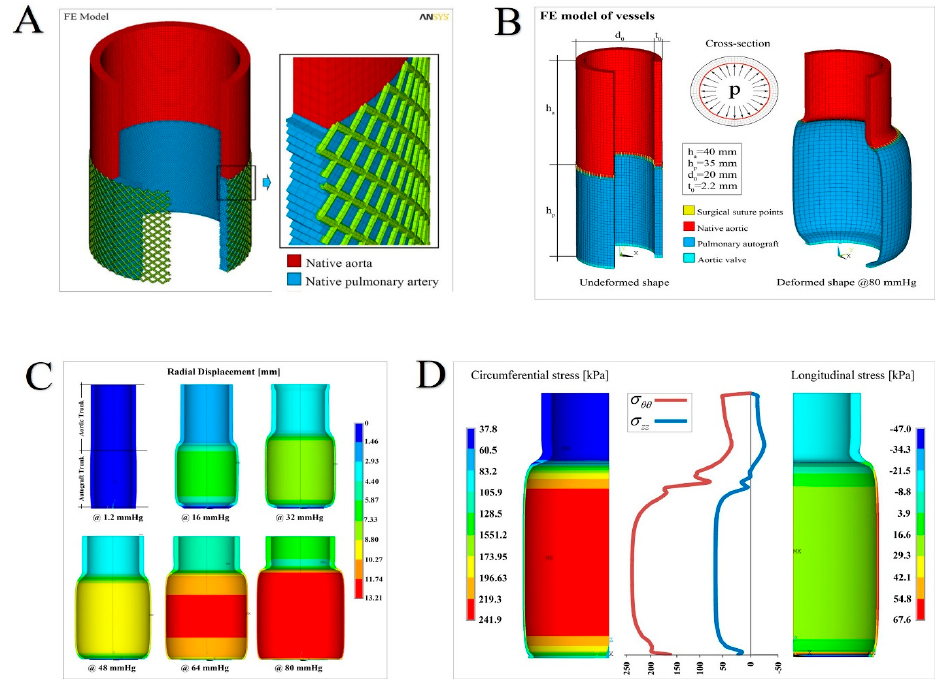
Figure 4. ( A ) Pulmonary autograft reinforced with semiresorbable prosthetics integrated into the pulmonary autograft wall. Right. The geometry of the finite element (FE) model, with a detail showing the communication of the native aorta (in red) with the pulmonary artery tract (blue), integrated with the external e-PTFE structure at the time of full development (BSA 2.2) ( B ) Overall sketch of the finite element model reconstruction of the aorta–suture–autograft–annulus ensemble: undeformed system (left); deformed (at the maximum pressure level) model (right) and cross-section with applied pressure. At the bottom, the legend with the details of the elements used and distinguished for material properties. ( C ) Sequence of deformations at increasing pressure levels up to 80 mmHg. The contour plots refer to the displacements along the radial direction (in mm). ( D ) Hoop (circumferential) and longitudinal (axial) stress profiles as a function of the vessel axis (middle), with contour plot details showing the spatially inhomogeneous distribution of the stresses (in kPa).